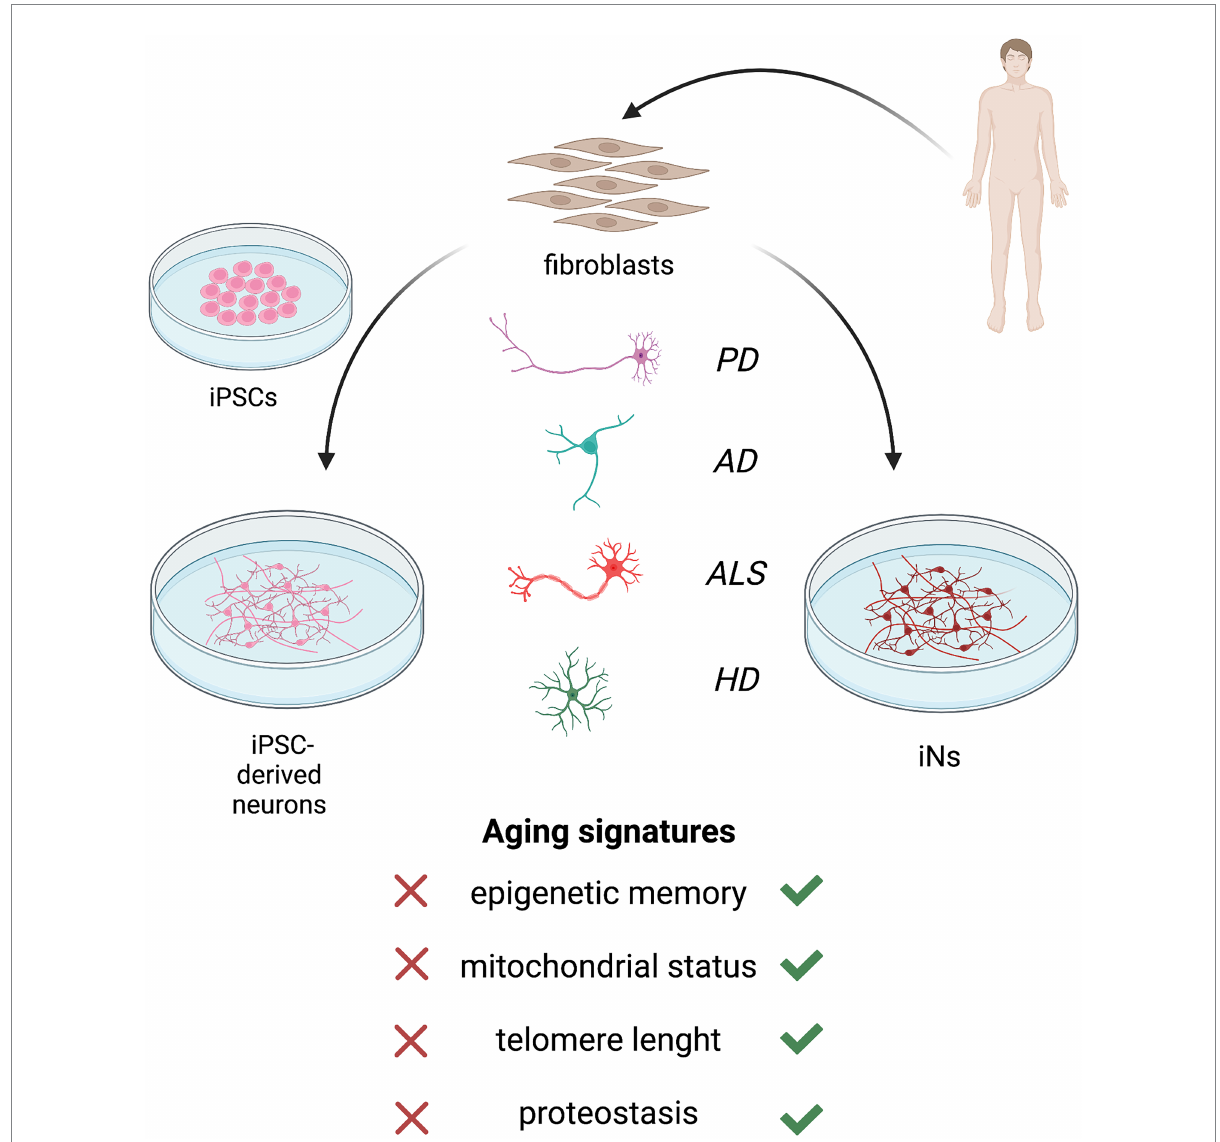
FIGURE 3 Patients’ fibroblast can be converted into neurons via induced pluripotent stem cell (iPSC)-based reprogramming (left) or direct reprogramming (right) . Both the approaches allow to obtain human neuronal models of neurodegenerative diseases, including Parkinson’s disease (PD), Alzheimer’s disease (AD), amyotrophic lateral sclerosis (ALS) and Huntington’s disease (HD). However, neurons and neuronal subtypes derived from iPSCs do not retain the main aging hallmarks of donor fibroblasts which are required for a reliable model of late-onset neurodegeneration. The induction of pluripotency reverts the cell age to an embryonic-like state, resetting epigenetic age, mitochondrial function, telomeres length, and proteostasis. Instead, direct reprogramming of induced neurons (iNs) bypasses the pluripotent intermediate state and retains the age of patients’